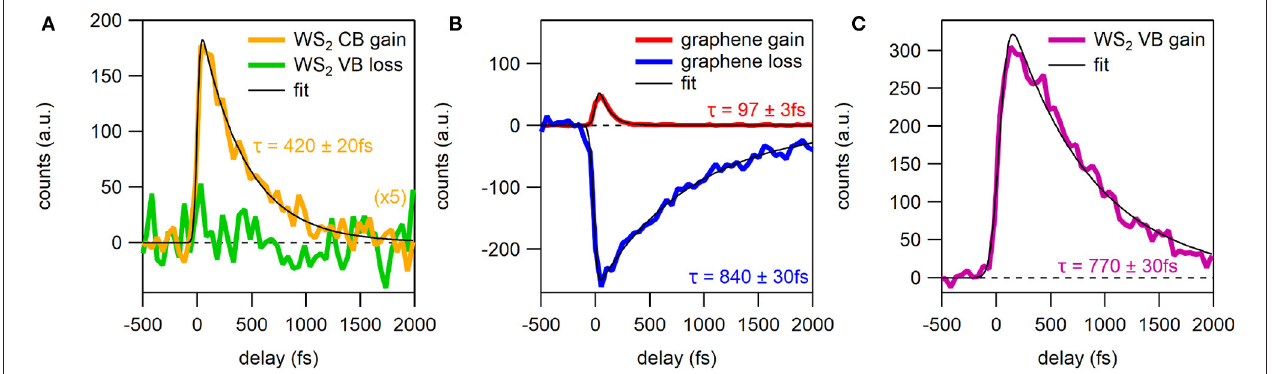
FIGURE 4 | Population dynamics of WS 2 and graphene states. (A) Transient occupation of WS 2 conduction band (CB, orange) and valence band (VB, green). The curves were obtained by integrating the photocurrent over the energy range marked by the orange and green brackets in Figure 3A for CB and VB, respectively. (B) Transient photocarrier dynamics of graphene. The curves were obtained by integrating the photocurrent over the energy range marked by the red and blue brackets in Figure 3B corresponding to the gain above E F and the loss below E F , respectively. (C) Photocurrent integrated over the energy range marked by the purple bracket in Figure 3C as a function of pump-probe delay. Black lines are exponential fits to data.